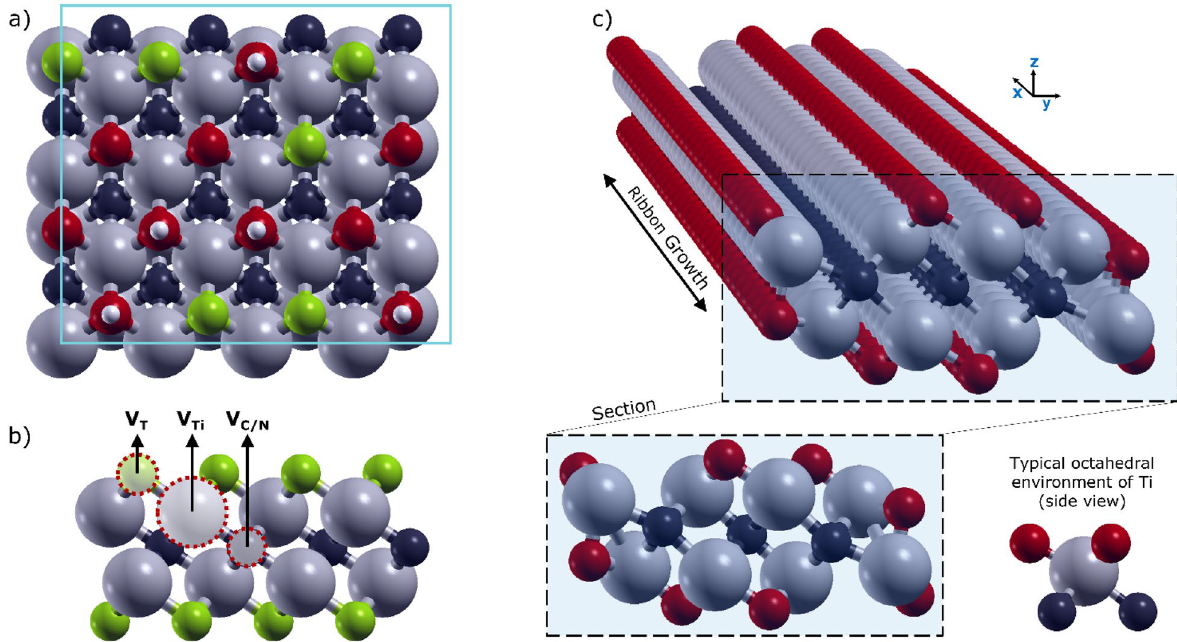
Fig. 1 a Top-view of the 4 4 orthorhombic cell employed for the mixed terminated MXene surface. The supercell is also representative of × homogeneously terminated surfaces. b Schematic of the single atomic defects considered: termination (V T ), titanium (V Ti ) and carbon/nitrogen (V C/N ) vacancies. c Perspective view (above) and cross-section (below) of the Ti 8 C 3 O 8 nanoribbon, that we used for the edge effect oxidation. In the lower right corner, we provided a schematic of the octahedral coordination usually found for Ti atoms in MXenes, which instead is distorted in nanoribbons. Chemical elements are represented by different colors: Ti-grey, C-black, F-green, O-red,